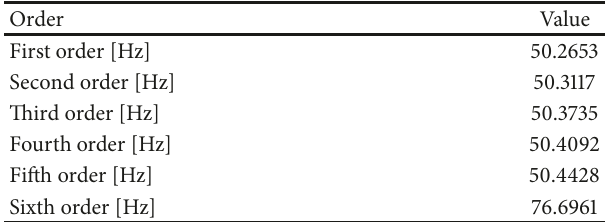
Table 11: The first six-order mode natural frequency of drag rotor.